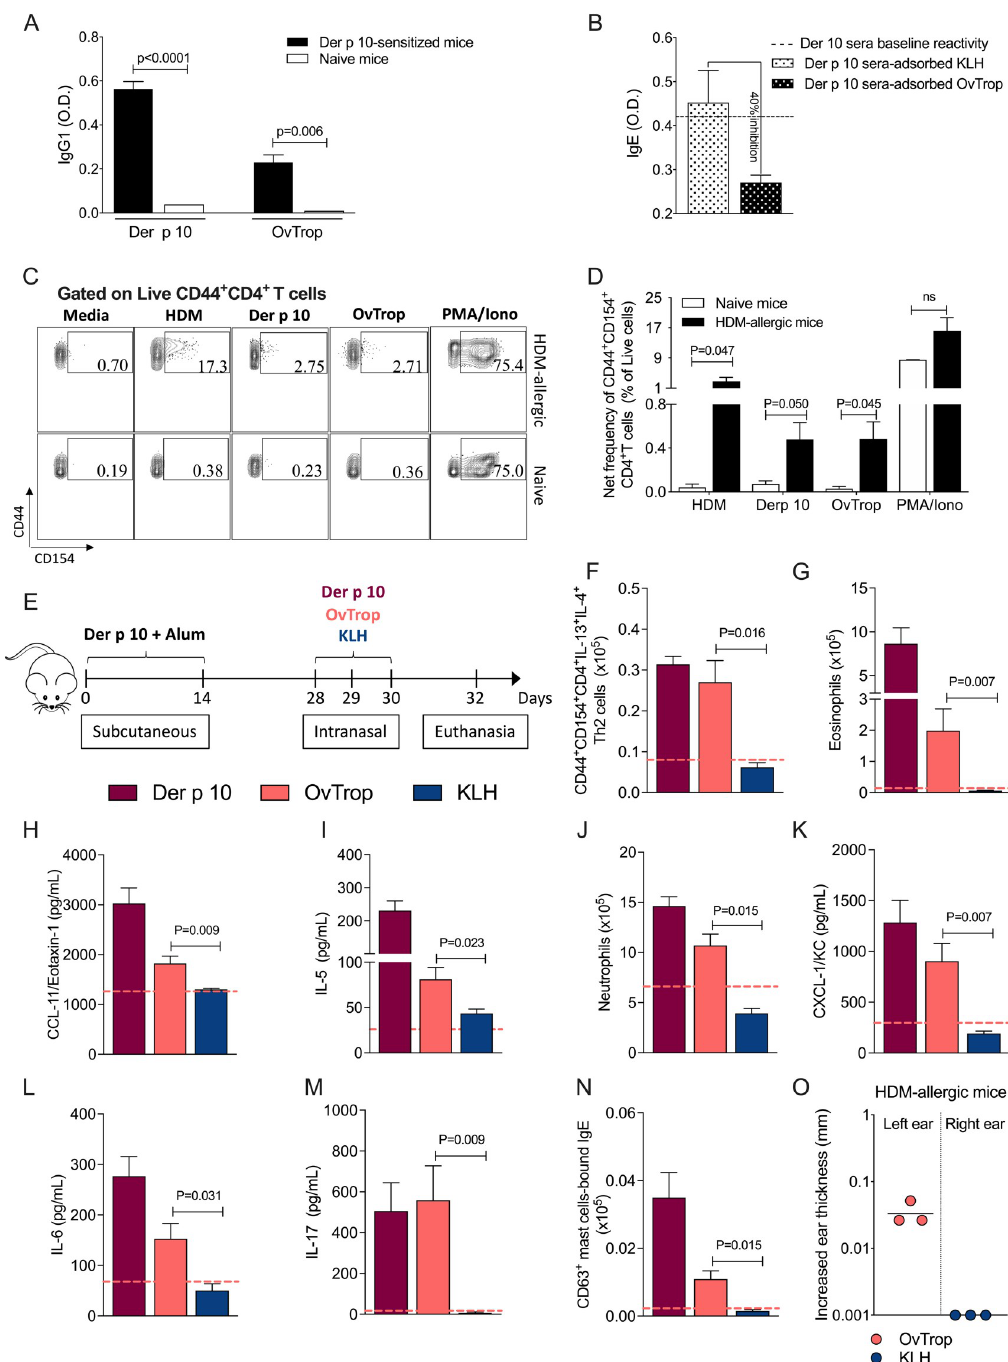
Fig 7. Homologous helminth proteins exacerbate pulmonary type-2 allergic inflammation in house dust mite presensitized mice. (A) Der p 10- and OvTrop-specific IgG1 levels in serum pools from na ï ve and Der p 10-sensitized mice. (B) Competitive ELISA assay for Der p 10-specific IgE reactivity using OvTrop-adsorbed Der p 10-sera, a non-related protein (KLH)-adsorbed Der p 10-sera, as well as a non-adsorbed Der p 10-sera (dotted line). (C) In vivo cross-sensitization model to test the capacity of the helminth tropomyosin (OvTrop) to elicit a pulmonary type-2 allergic inflammation in Der p 10-systemically presensitized mice. Balb/c mice were sensitized by subcutaneously with rDer p 10-alum on days 0 and 14. On days 28–30, mice were challenged intranasally with either rDer p 10, rOvTrop or KLH. Non-sensitized mice but challenged with the proteins were used as controls (pink dotted line for OvTrop). (D-M) The characterization of the lung inflammation by immunophenotypic flow cytometry analysis of memory antigen-specific Th2 effector cells, Siglec-F + eosinophils, Ly6G +